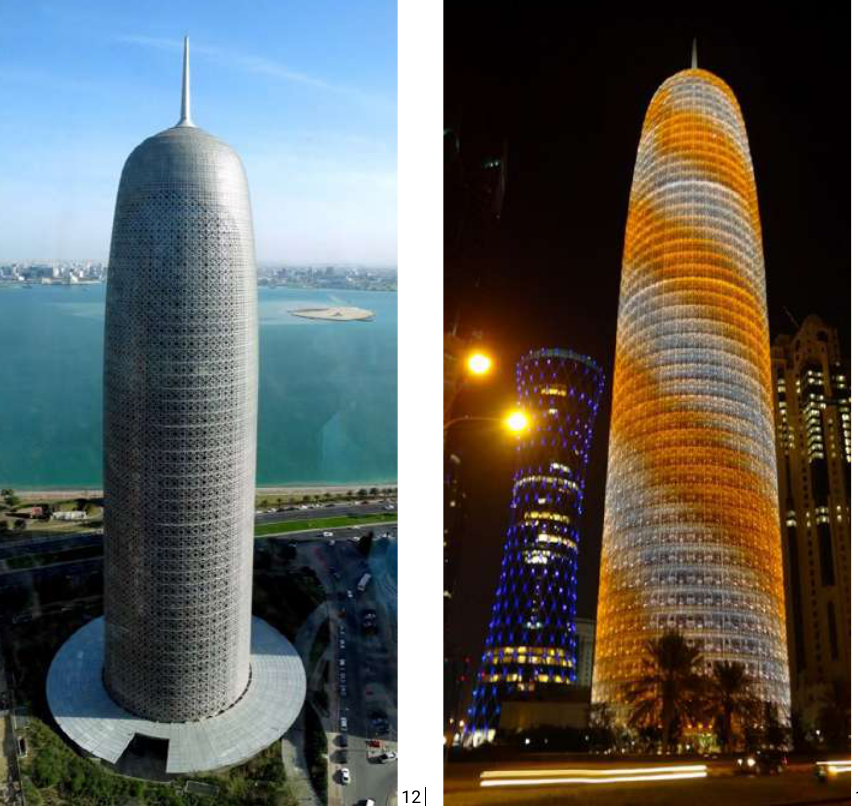
The Burj Qatar (Source: Peter Chomowicz,